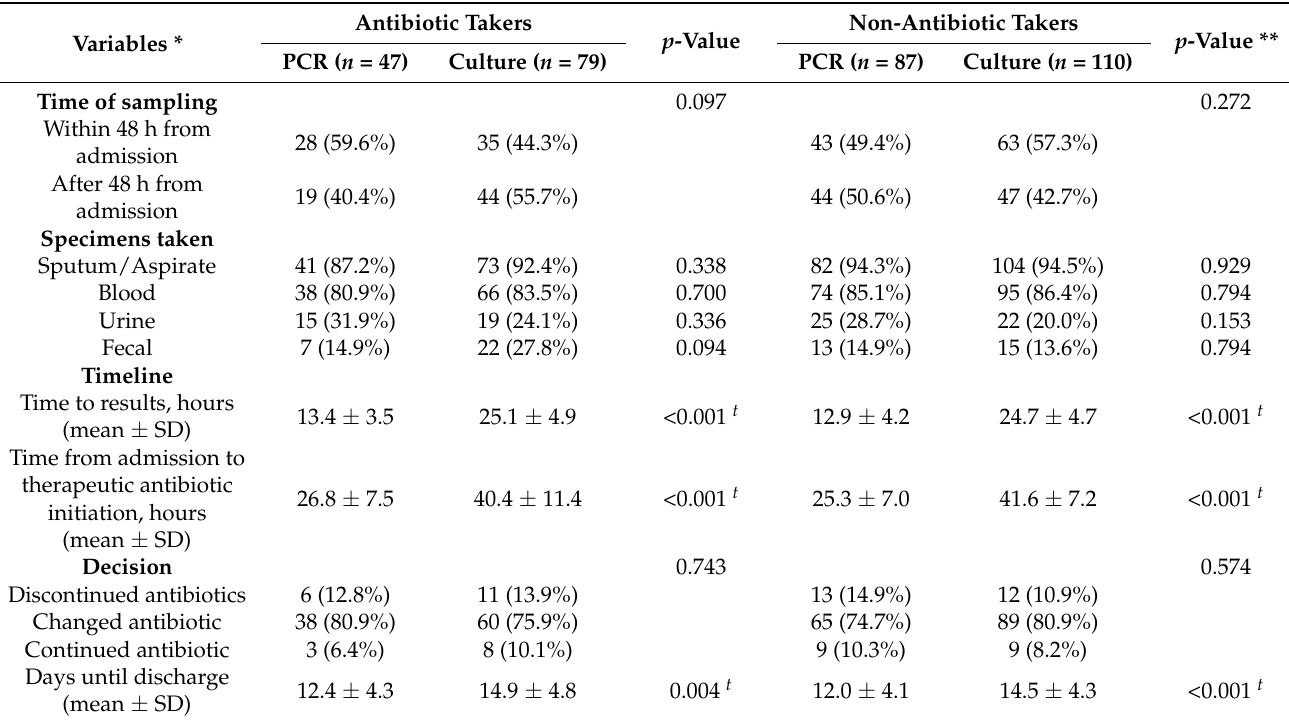
Figure 3. Parallel results of antimicrobial drug resistance pattern in non-antibiotic takers ( n = 94) and antibiotic takers ( n = 72), identified by multiplex PCR and conventional bacterial cultures. DR—drug resistance. Table 5. Comparison of COVID-19 patient outcomes stratified by antibiotic use and type of bacterial identification test